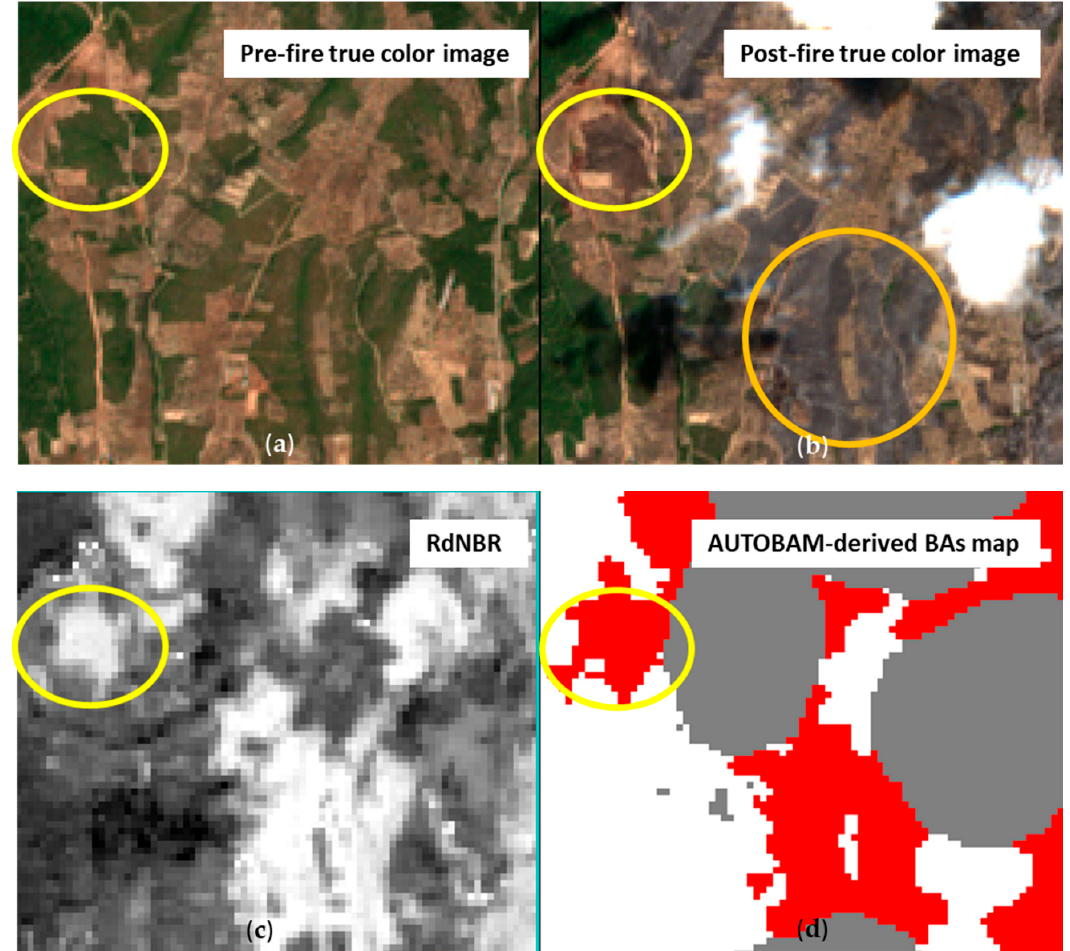
Figure 10. Zoom on a portion of the area of interest for the Evia Island test case, where a false alarm occurs (yellow circles); ( a ) pre-fire true color image; ( b ) post-fire true color image; ( c ) RdNBR map; ( d ) AUTBAM-derived burned areas map.